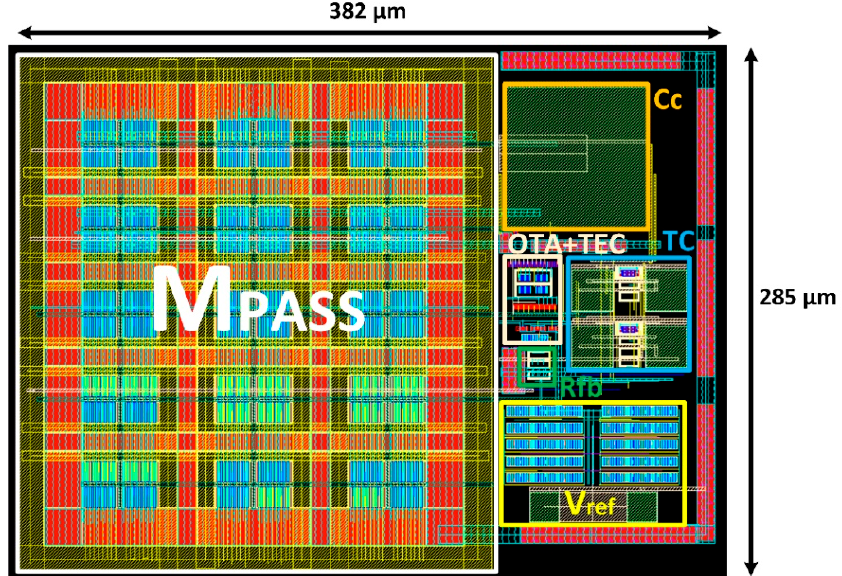
Figure 9. Layout view of the proposed low-dropout regulator.